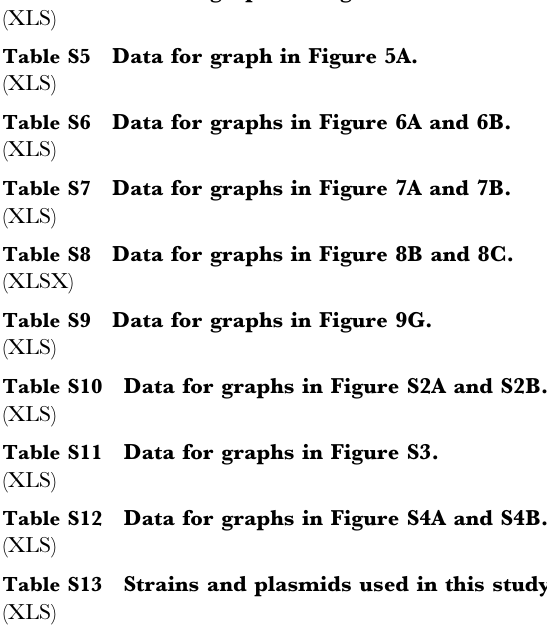
Table S3 Genetic interactions with EMC6 , related to Figure 2. Aggravating and alleviating genetic interactions identified by SGA analysis are listed along with the strength of the interactions, plotted as in Table S1. Table S4 Data for graphs in Figure 4A and 4C. Table S5 Data for graph in Figure 5A. Table S6 Data for graphs in Figure 6A and 6B. Table S7 Data for graphs in Figure 7A and 7B. Table S8 Data for graphs in Figure 8B and 8C. Table S9 Data for graphs in Figure 9G. Table S10 Data for graphs in Figure S2A and S2B. Table S11 Data for graphs in Figure S3. Table S12 Data for graphs in Figure S4A and S4B. Table S13 Strains and plasmids used in this